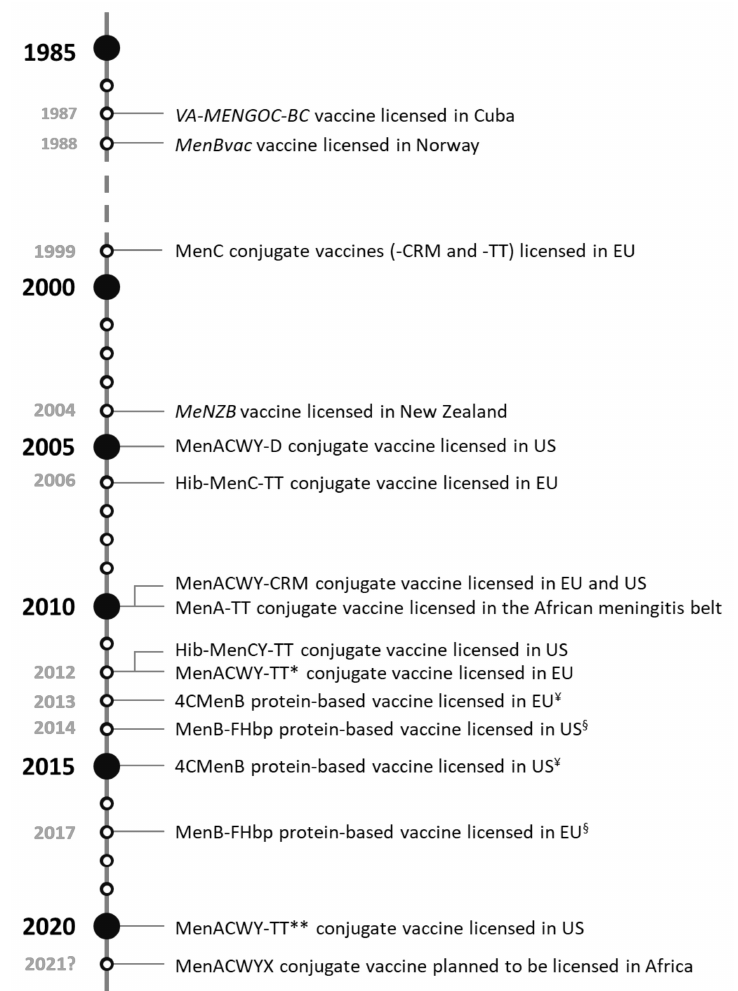
Figure 2. Timeline of the licensure of meningococcal conjugate, OMV-based and protein-based vaccines. VA-MENGOC-BC (Finlay Institute), OMV-based vaccine licensed in Cuba; MenBvac (Norwegian Institute of Public Health), OMV-based vaccine licensed in Norway; MenC-CRM ( Meningitec , Nuron Biotech and Menjugate , GSK), meningococcal serogroup C conjugate vaccine conjugated to diphtheria protein cross-reactive material 197; MenC-TT ( NeisVac-C , Pfizer), meningococcal serogroup C conjugate vaccine conjugated to tetanus toxoid; CRM, diphtheria protein cross-reactive material 197; TT, tetanus toxoid; EU, European Union; MeNZB (Novartis), OMV-based vaccine licensed in New Zealand; MenACWY-D ( Menactra, Sanofi Pasteur), quadrivalent meningococcal conjugate vaccine conjugated to diphtheria toxoid; USA, United States; Hib-MenC-TT ( Menitorix, GSK), Haemophilus influenzae type b- Neisseria meningitidis serogroup C-tetanus-toxoid conjugate vaccine; MenACWY-CRM ( Menveo, GSK), quadrivalent meningococcal conjugate vaccine conjugated to diphtheria protein cross-reactive material 197; MenA-TT (PsA-TT, MenAfriVac , Serum Institute of India), monovalent meningococcal serogroup A conjugatevaccineconjugatedtotetanustoxoid; Hib-MenCY-TT( MenHibrix , GSK), Haemophilusinfluenzae type b- Neisseria meningitidis serogroups C and Y-tetanus-toxoid conjugate vaccine; MenACWY-TT* ( Nimenrix , Pfizer), quadrivalent meningococcal conjugate vaccine conjugated to tetanus toxoid; 4CMenB ( Bexsero, GSK), 4-component meningococcal serogroup B protein-based vaccine; MenB-FHbp ( Trumenba , Pfizer), bivalent meningococcal serogroup B protein-based vaccine; MenACWY-TT** ( MenQuadfi , Sanofi Pasteur), quadrivalent meningococcal conjugate vaccine conjugated to tetanus toxoid; MenACWYX ( NmCV-5 , Serum Institute of India), pentavalent meningococcal conjugate vaccine. ¥ 4CMenB is licensed for use in infants from 2 months of age in the EU and in 10–25-year-olds in the USA; § MenB-FHbp is licensed for use in individuals aged 10 years and older in the EU and in 10–25-year-olds in the